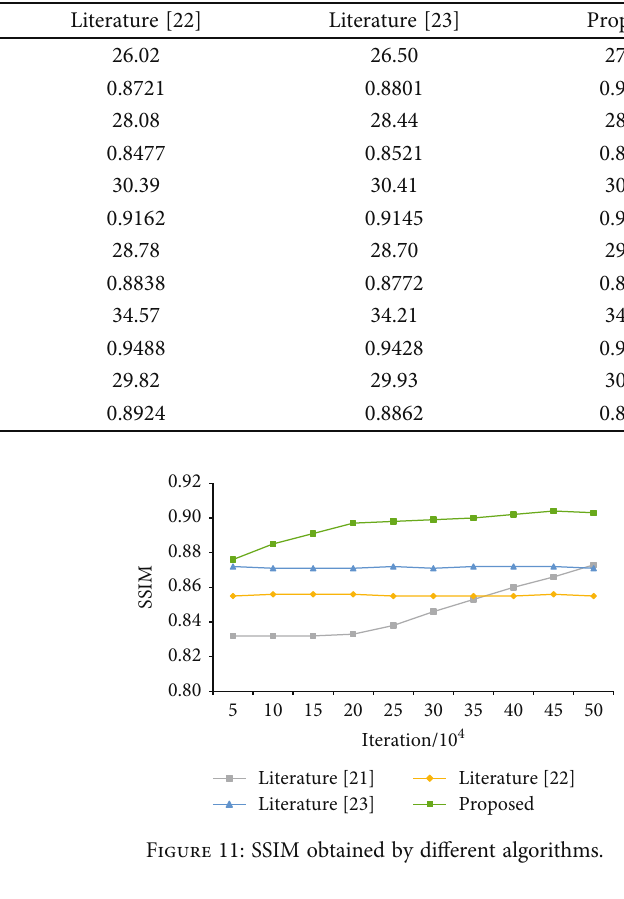
Table 1: Comparison of PSNR and SSIM indicators.